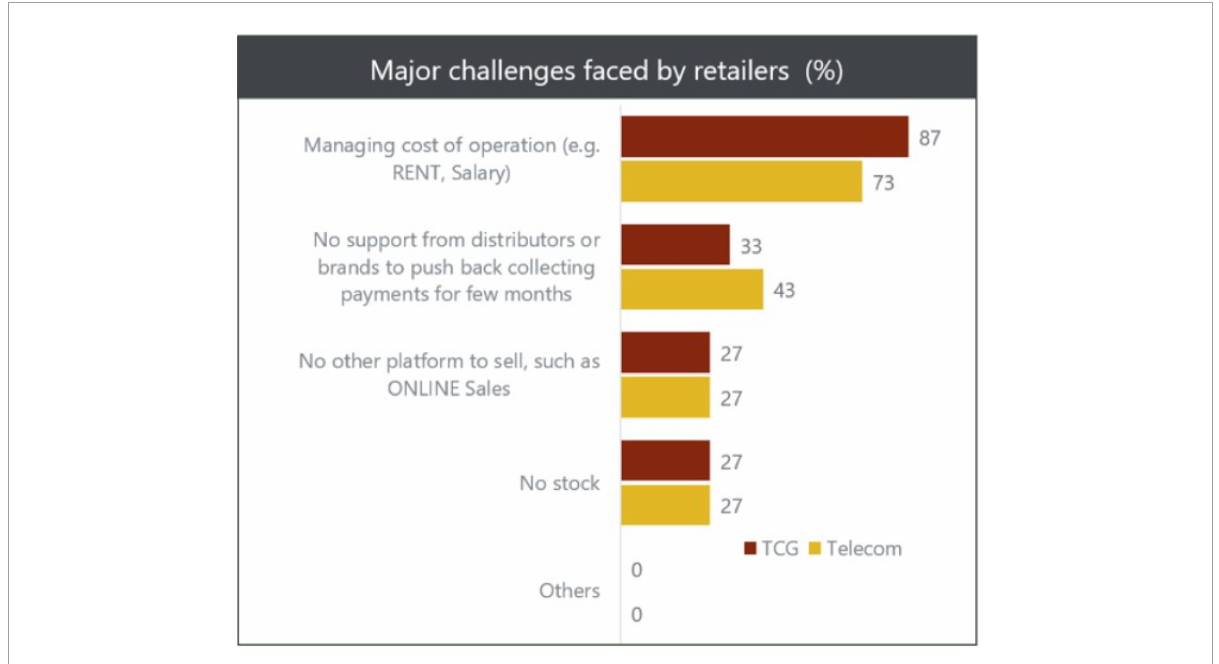
FIGURE1 COVID-19 Impact on Retailer Sentiments in Pakistan,